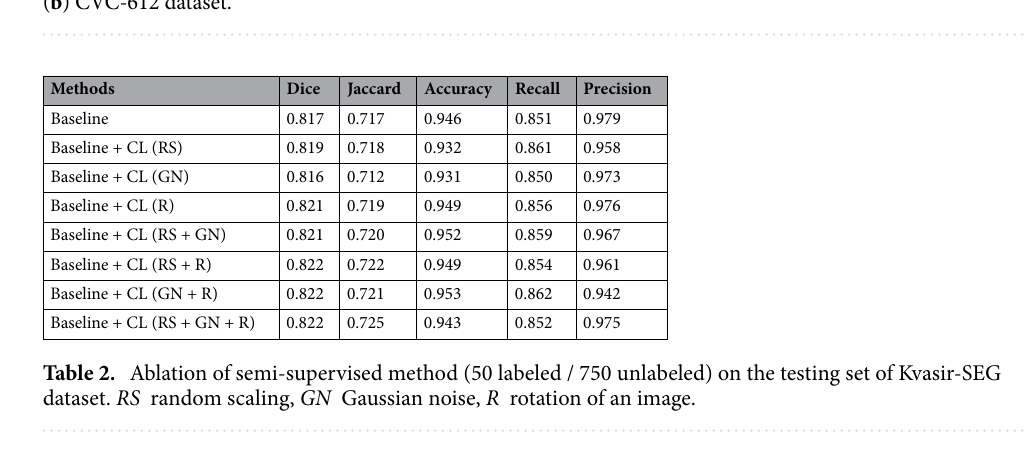
Figure 4. The Dice coefficient score under different distribution of labeled/unlabeled sets in ( a ) Kvasir-SEG and ( b ) CVC-612 dataset.